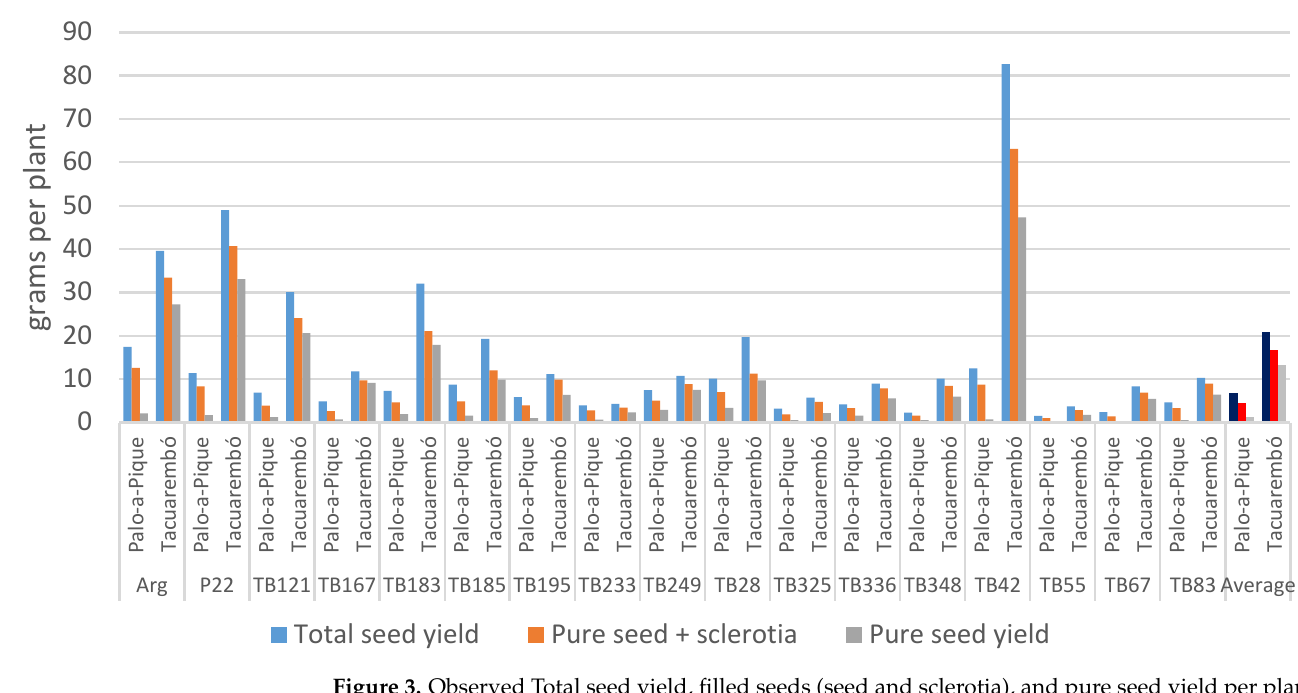
Figure 3. Observed Total seed yield, filled seeds (seed and sclerotia), and pure seed yield per plant summarized by genotype and location. Location averages represented in darker colors. Table 4. Pearson correlation coefficients and probabilities between total seed yield